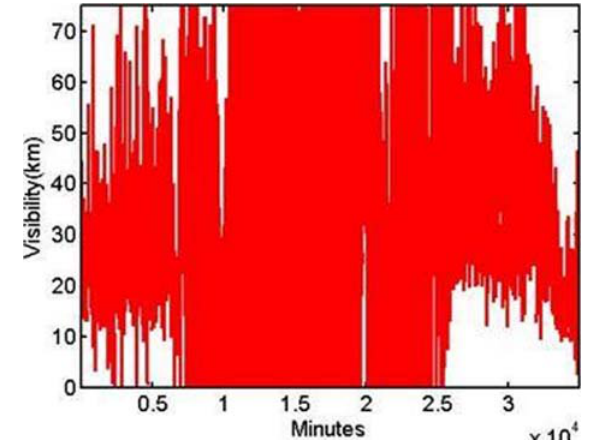
FIG. 8. TIME SERIES PLOT OF ESTIMATED SPECIFIC OPTICAL ATTENUATION BY KRUSE MODEL FOR THE YEAR 2011